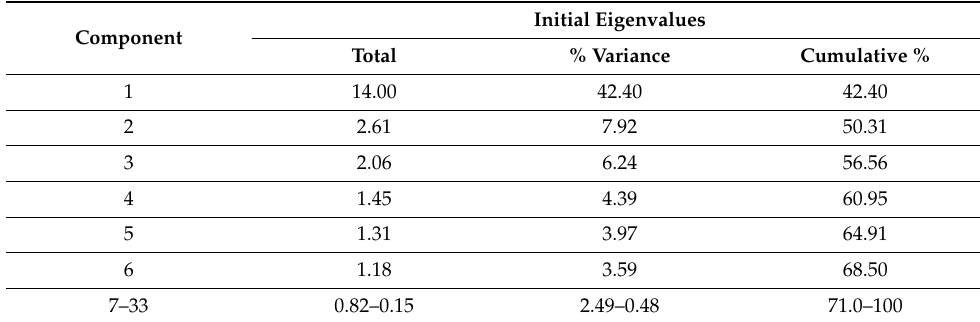
Table 1. Cumulative values of variance for the six main